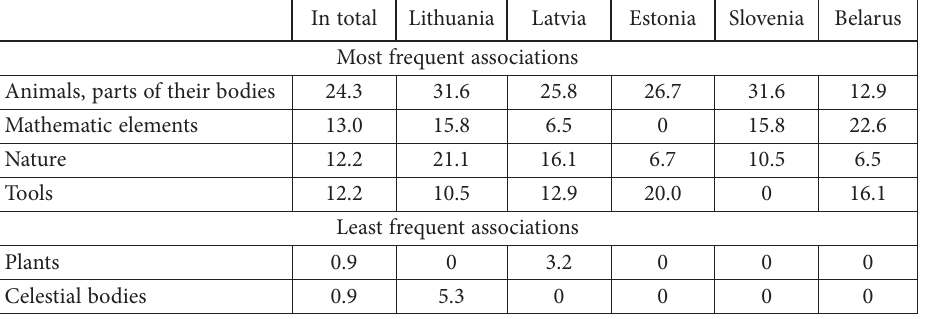
Table 3. Associations of Fragment 2 (%) (source: created by authors) In total